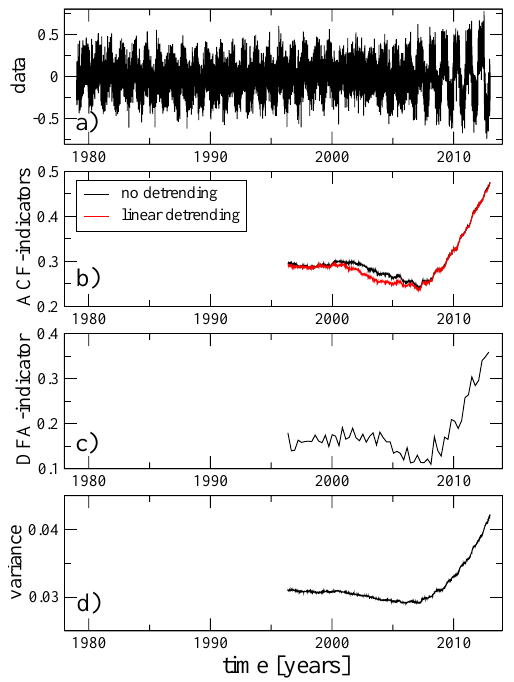
Fig. 5. Search for early warning signals of bifurcation in Arctic sea-ice area data. (a) Sea-ice area anomaly (as in Fig. 2a) showing the quadratic downward trend that is removed prior to calculating the instability indicators. Right panels show example indicators us- ing a sliding window of length half the series, with results plotted at the end of the sliding window. Indicators from (c) autocorrela- tion function (ACF), (e) detrended fluctuation analysis (DFA) and (g) variance. Left panels show histograms of the Kendall statistic for the trend in the indicators when varying the sliding window length from 1/4 to 3/4 of the series: (b) ACF-indicator; (d) DFA-indicator; (f) variance.